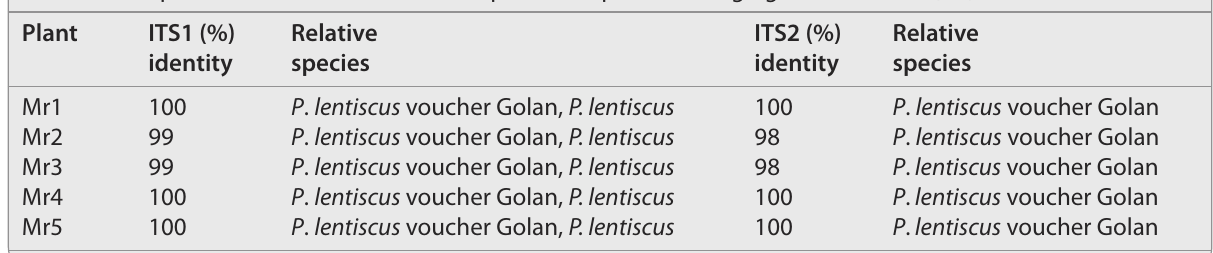
Table 5 Composition of the ITS1 and ITS2 sequences of plants belonging to “Maroulitis” (Mr) Plant